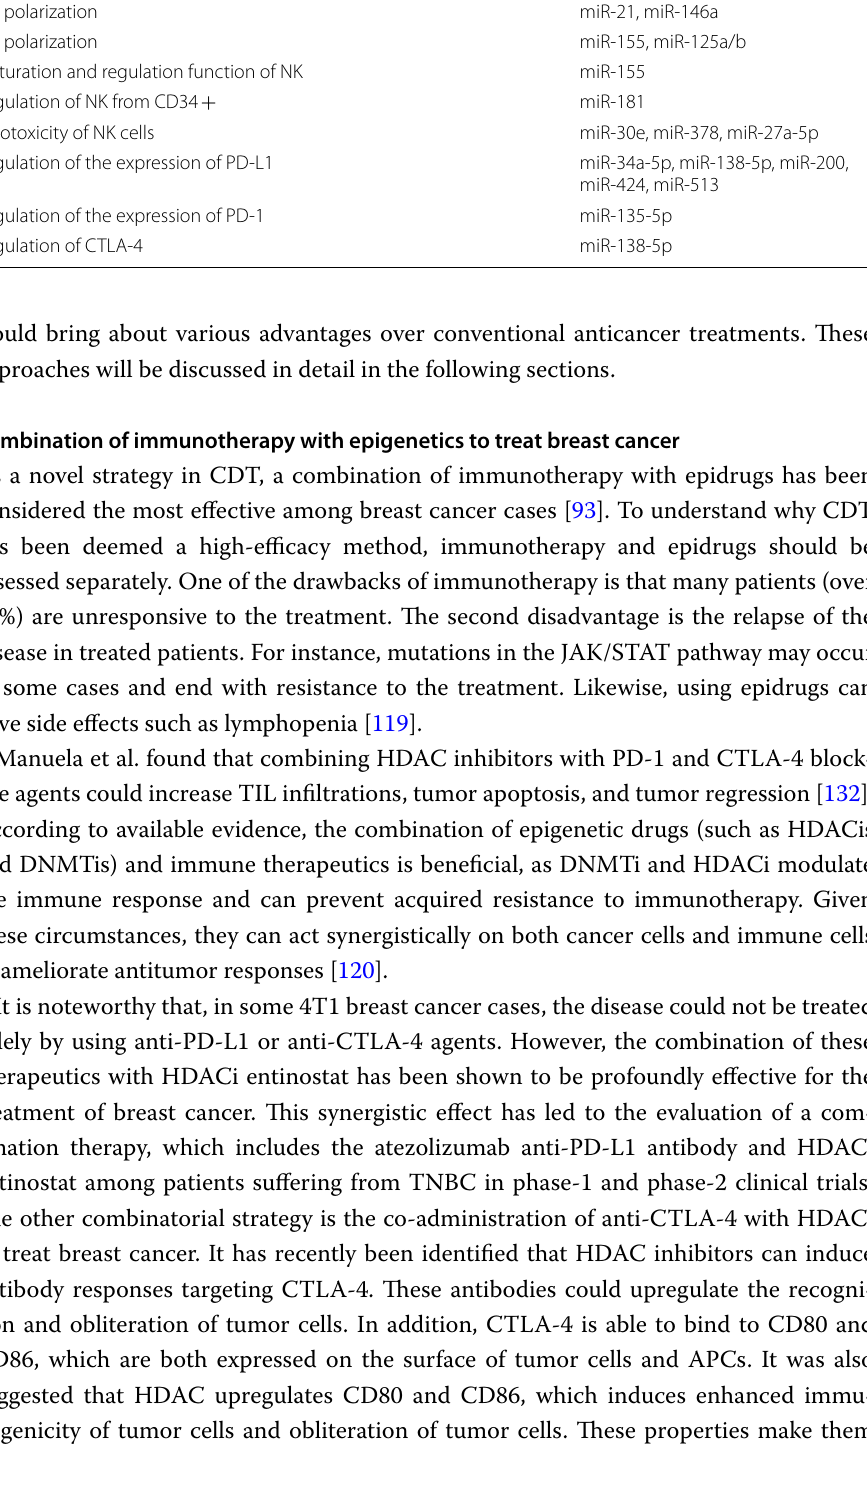
Table 4 The function of miRNAs in different immune cells [129] Function Inhibition of monocyte differentiation of